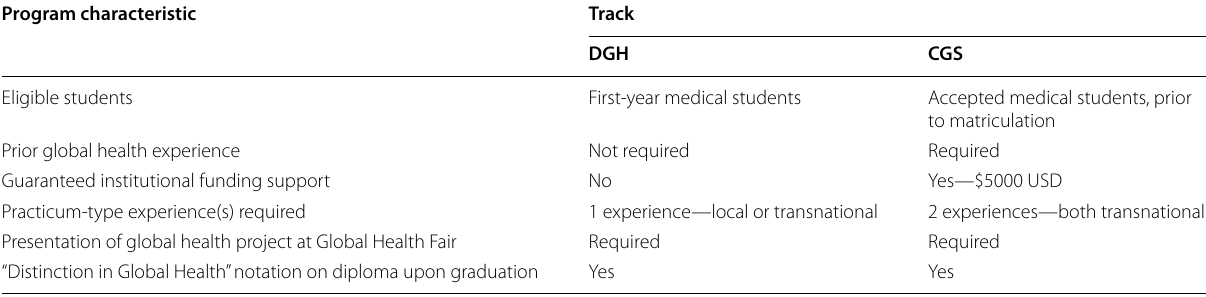
Table 1 Comparison of programmatic structure and characteristics for the Distinction in Global Health (DGH) and Chancellor’s Global Scholars (CGS) tracks Program